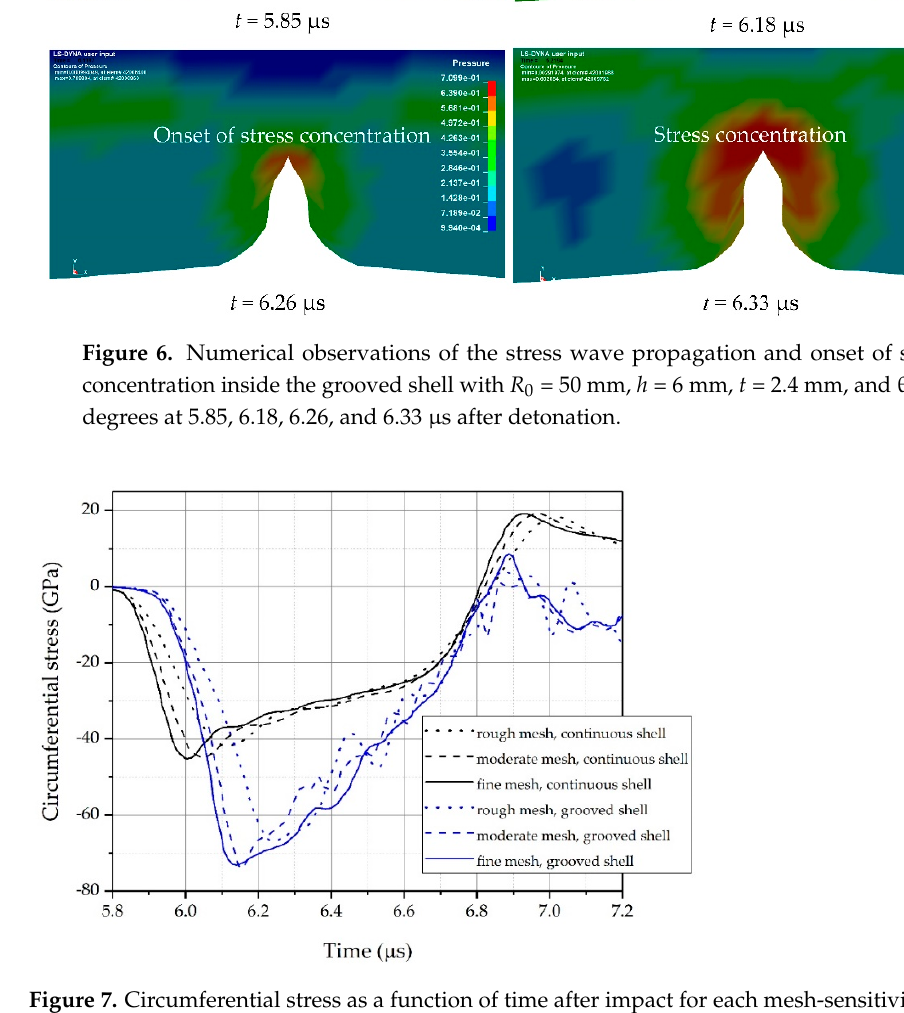
Figure 7. Circumferential stress as a function of time after impact for each mesh-sensitivity trial.